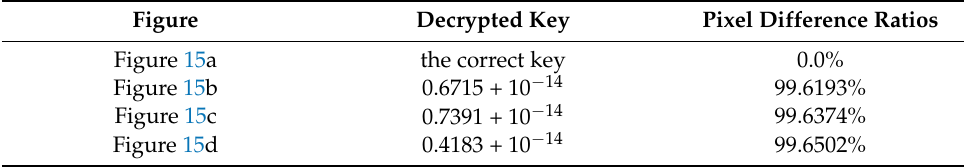
Table 4. Difference between decryption results from slightly modified keys. Figure